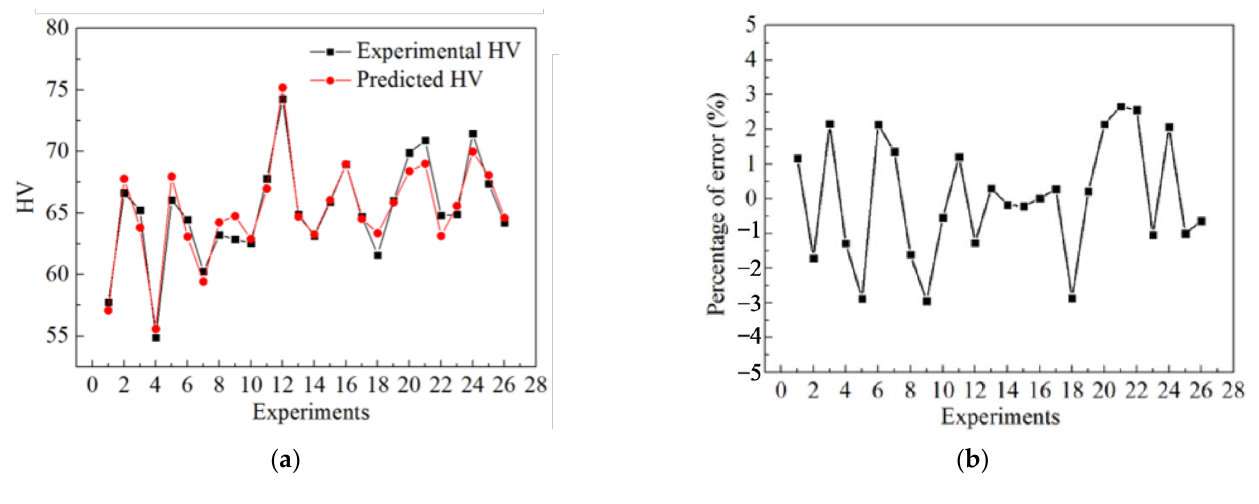
Figure 7. ( a ) Comparison of experimental and predicted results for HV; ( b ) percentage of error.